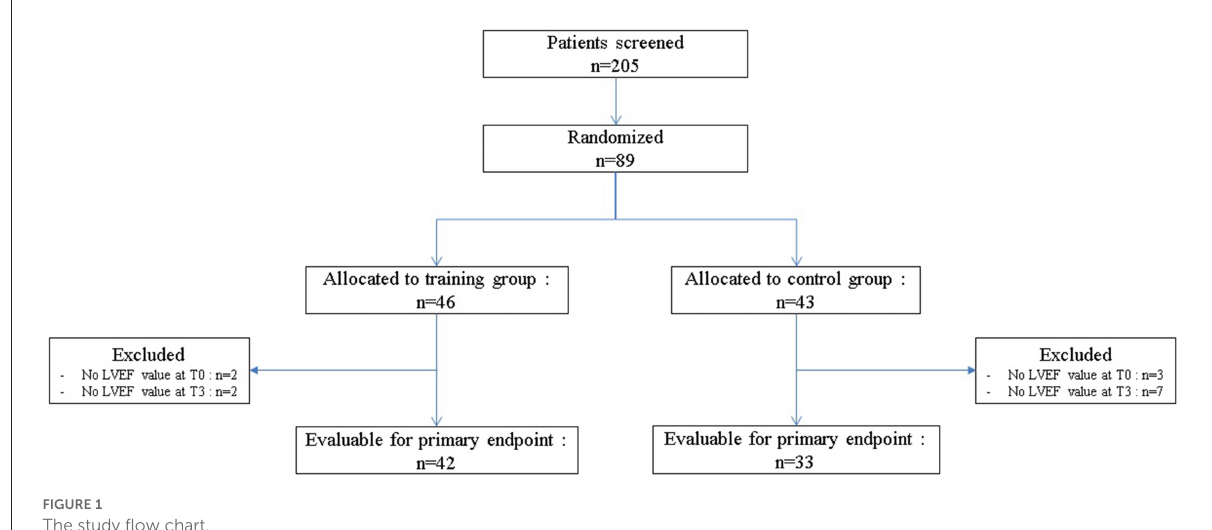
FIGURE1 The study flow